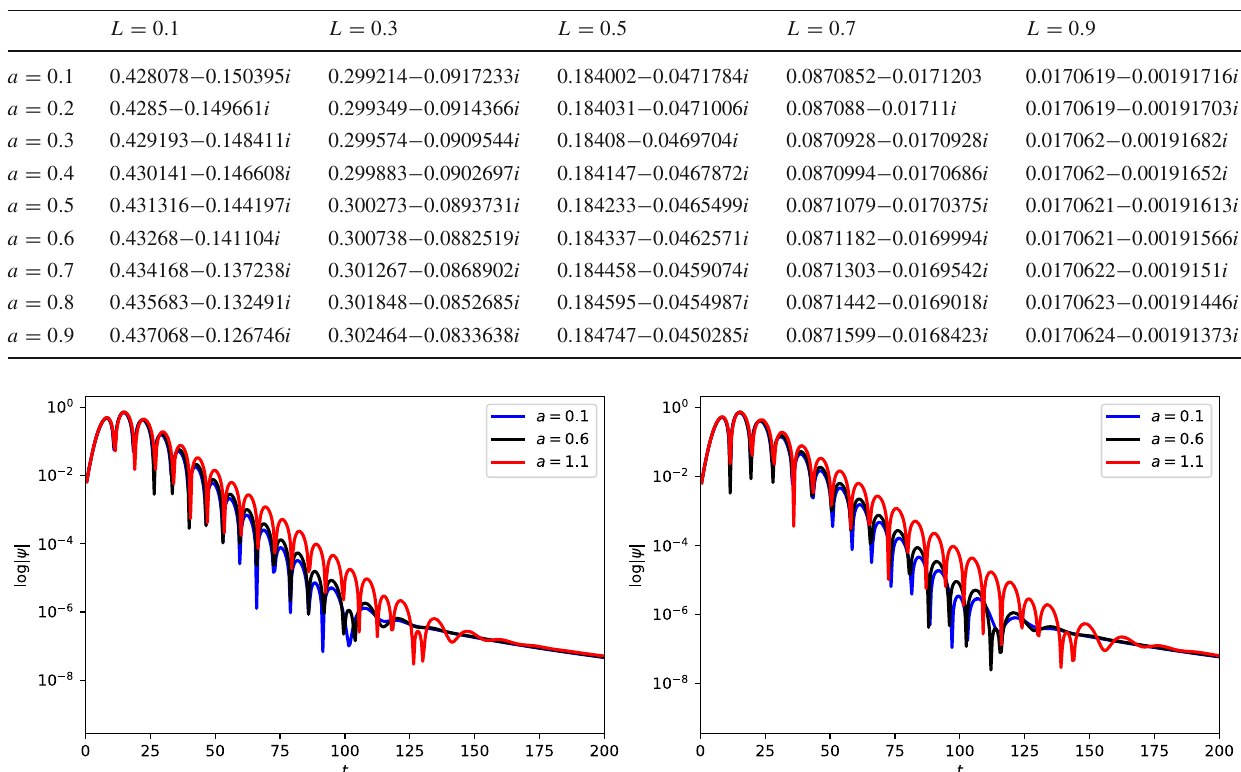
Fig. 4 The time-domain profiles of the scalar field perturbation (left panel) for different a with M = 0 . 5 , l = 1 , L = 0 . 1. The time-domain profiles of the electromagnetic field perturbation (right panel) for different a with M = 0 . 5 , l = 1 , L = 0 . 1